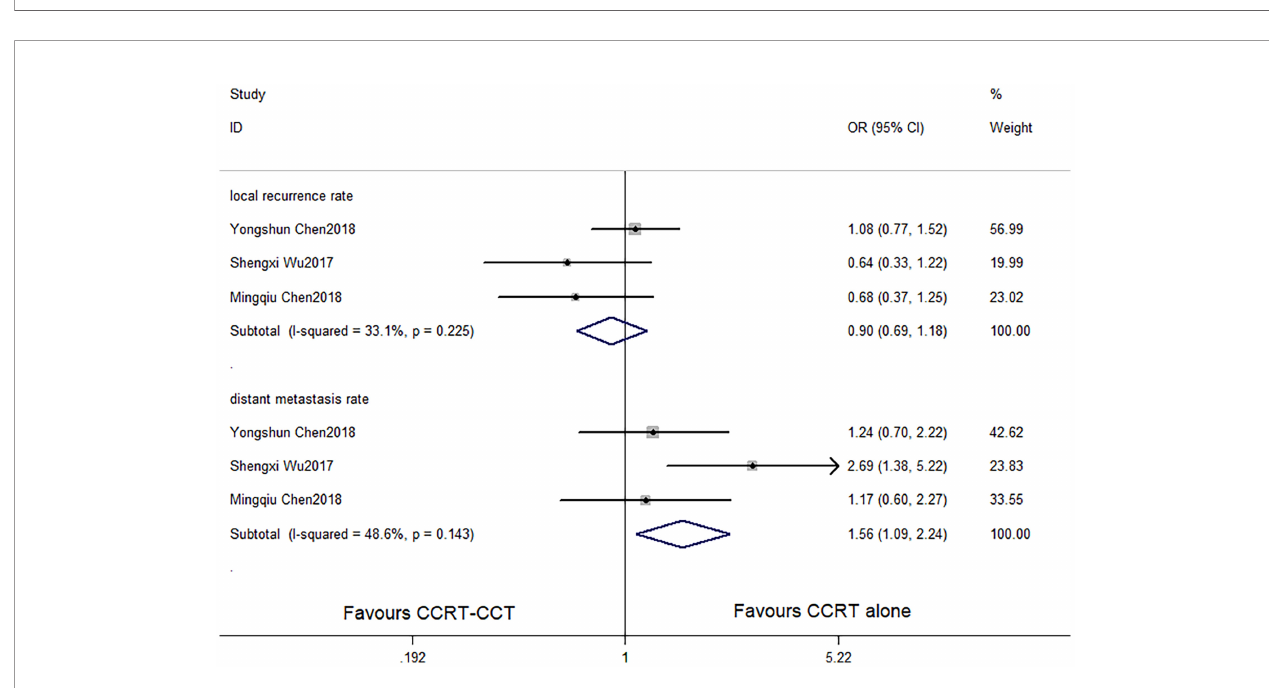
FIGURE 3 | Effects of CCRT-CCT vs . CCRT alone on 1-, 2-, 3-, and 5-year OS. CCRT-CCT, concurrent chemoradiotherapy followed by consolidation chemotherapy; CCRT, concurrent chemoradiotherapy; OS, overall survival; CI, con fi dence interval; ES, effect size.